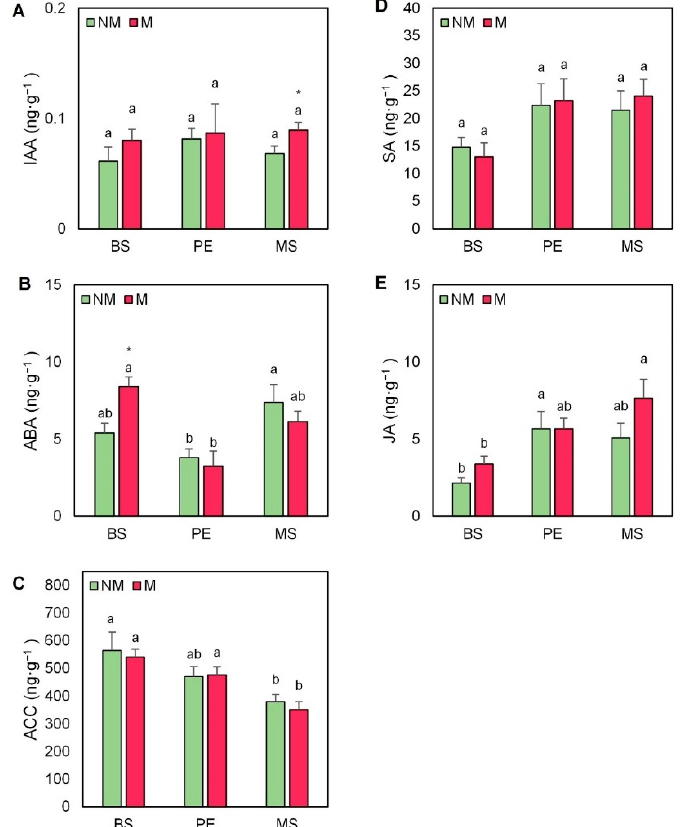
Figure 7. ( A ) Indole acetic acid (IAA), ( B ) abscisic acid (ABA), ( C ) 1-aminocyclopropane-1-carboxylic acid (ACC), ( D ) salicylic acid (SA), and ( E ) jasmonic acid (JA) concentrations in leaves of escarole plants of the commercial variety “Bekele” cultivated under non-mycorrhizal (NM) and mycor- rhizal (M) conditions and covered or not with mulching treatments. Bars show the means of five plants ± standard error. Different letters show significant differences among mulching treatments while the asterisk (*) indicates significant differences due to AMF inoculation within each mulching treatment according to Tukey’s and t -tests ( p ≤ 0.05). Abbreviations used: bare soil (BS), polyethylene mulch (PE), and mushroom substrate-based hydromulch